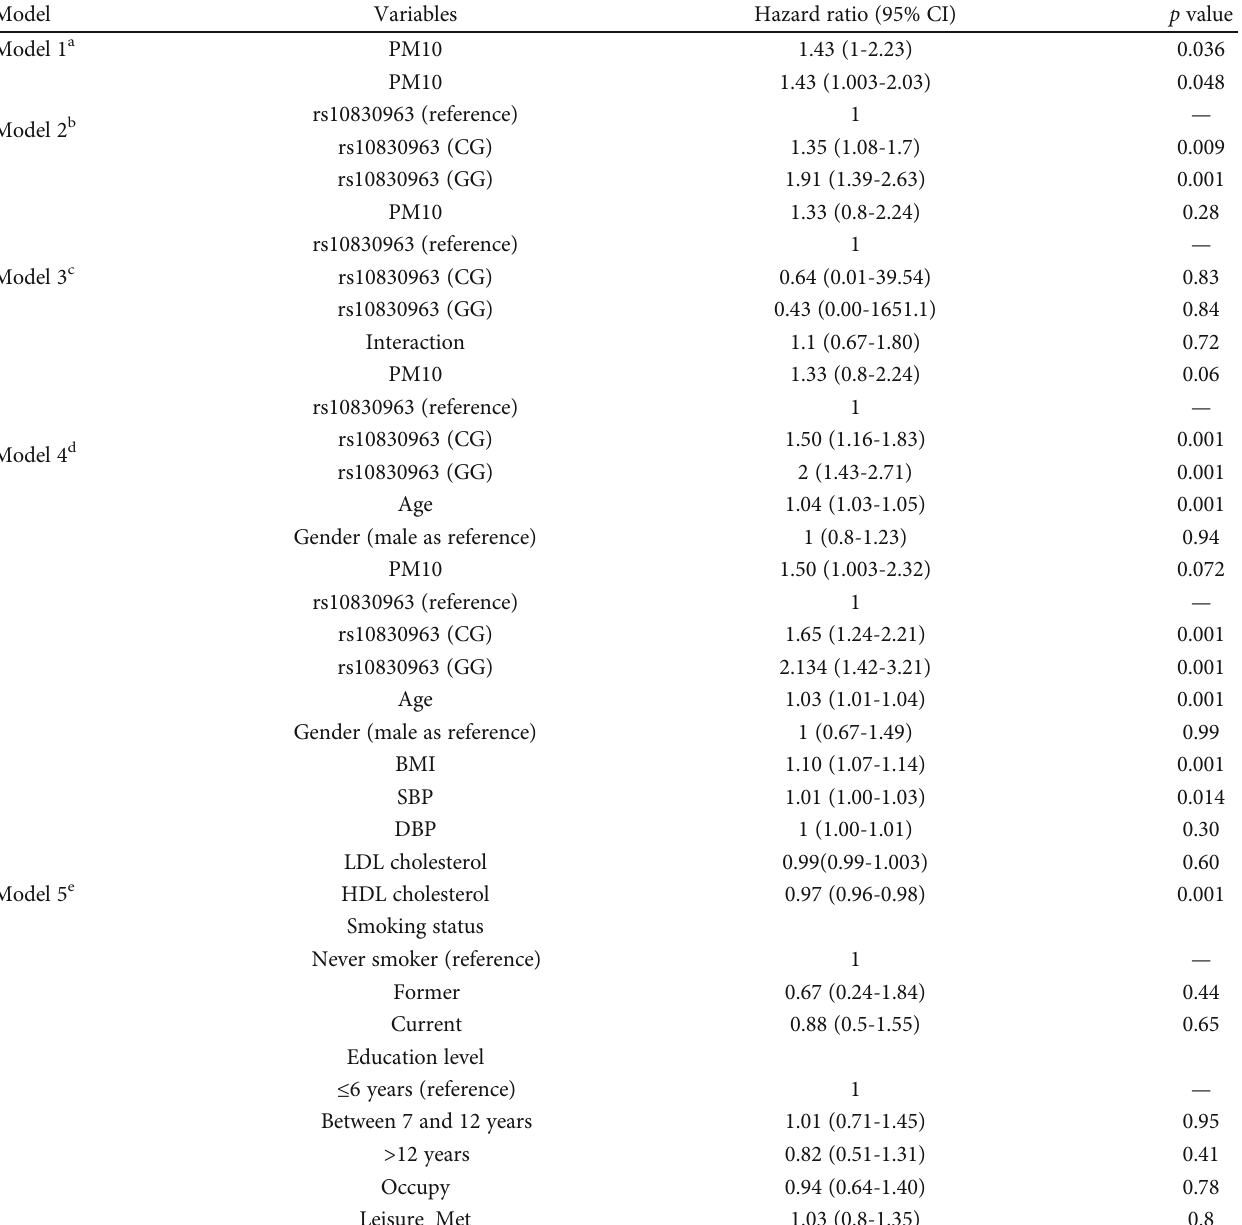
Table 3: Multivariable adjusted risk of type 2 diabetes with PM10 and